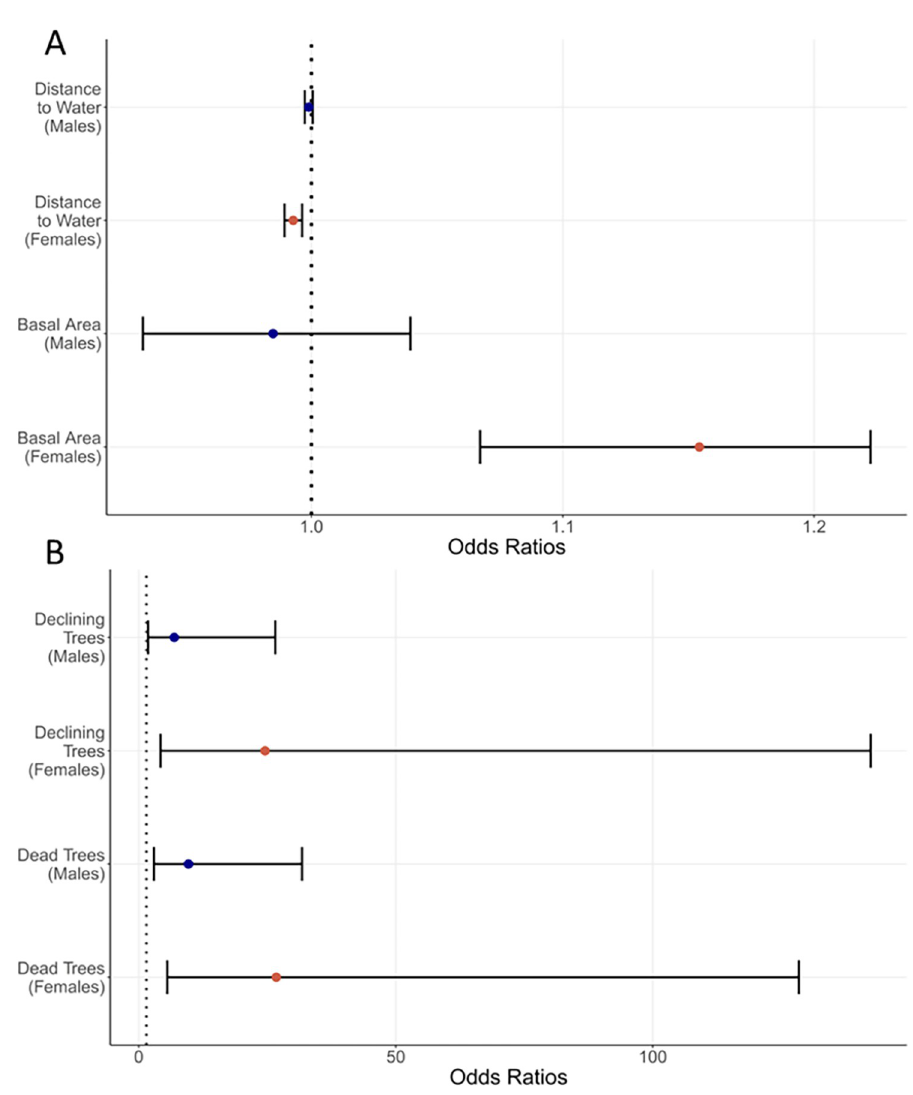
Fig 3. Tree- and stand-scale habitat variables influence the odds of roosting by northern myotis. Odds ratios and 95% confidence intervals for variables included in our top model describing day roost selection by northern myotis in central Pennsylvania. Panel A depicts distance to water and basal area apart from tree decay stage in Panel B to prevent obscuring smaller values. For decay stage, odds ratios are in reference to live